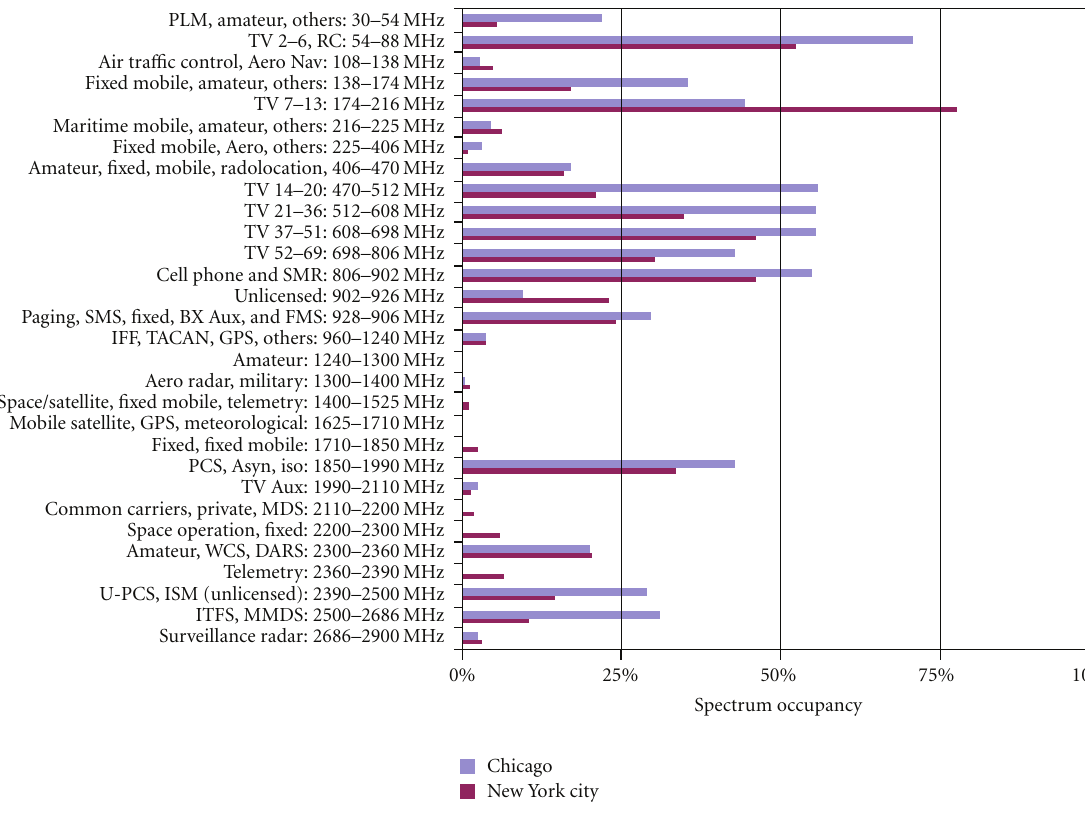
Figure 1: A measurement of 30M–3GHz spectrum